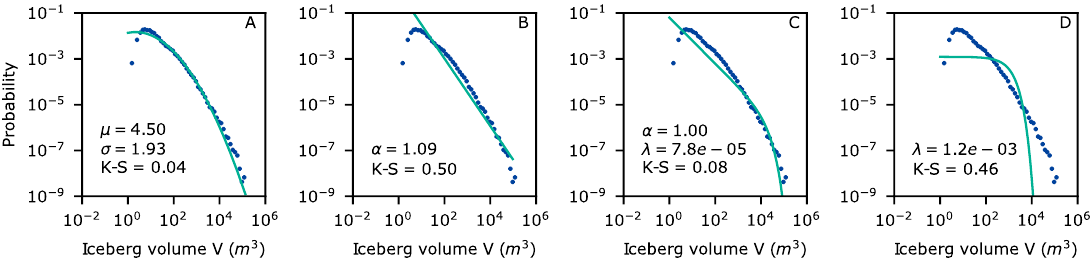
Figure 11. Fitting of heavy-tailed distributions (green lines) to logarithmically binned area data (blue dots): ( A ) log-normal P ( S = x ) = 1 ( C ) exponentially truncated power law P ( S = x ) = x α e λ x ; and ( D ) exponential P ( S = x ) = e λ x .